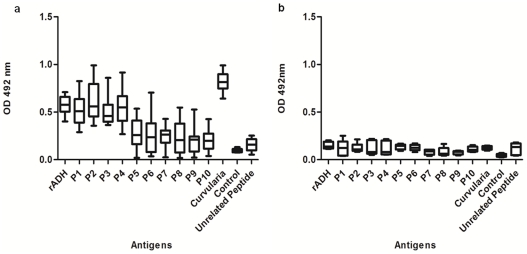
IgE binding studies.(a) B and T cell peptide binding was tested with 12 individual Curvularia hypersensitive patients' sera. Curvularia native, recombinant ADH or peptides were coated on ELISA plate and incubated with hypersensitive patients' sera. The IgE affinity was detected by HRP labelled anti human IgE. (b) Curvularia native, recombinant ADH or peptides were coated on ELISA plate, probed with sera from 5 healthy subjects and detected by HRP labelled anti human IgE. The data is presented as box and whiskers plot showing variation of IgE values from median. All values show p<0.05 as compared to control.